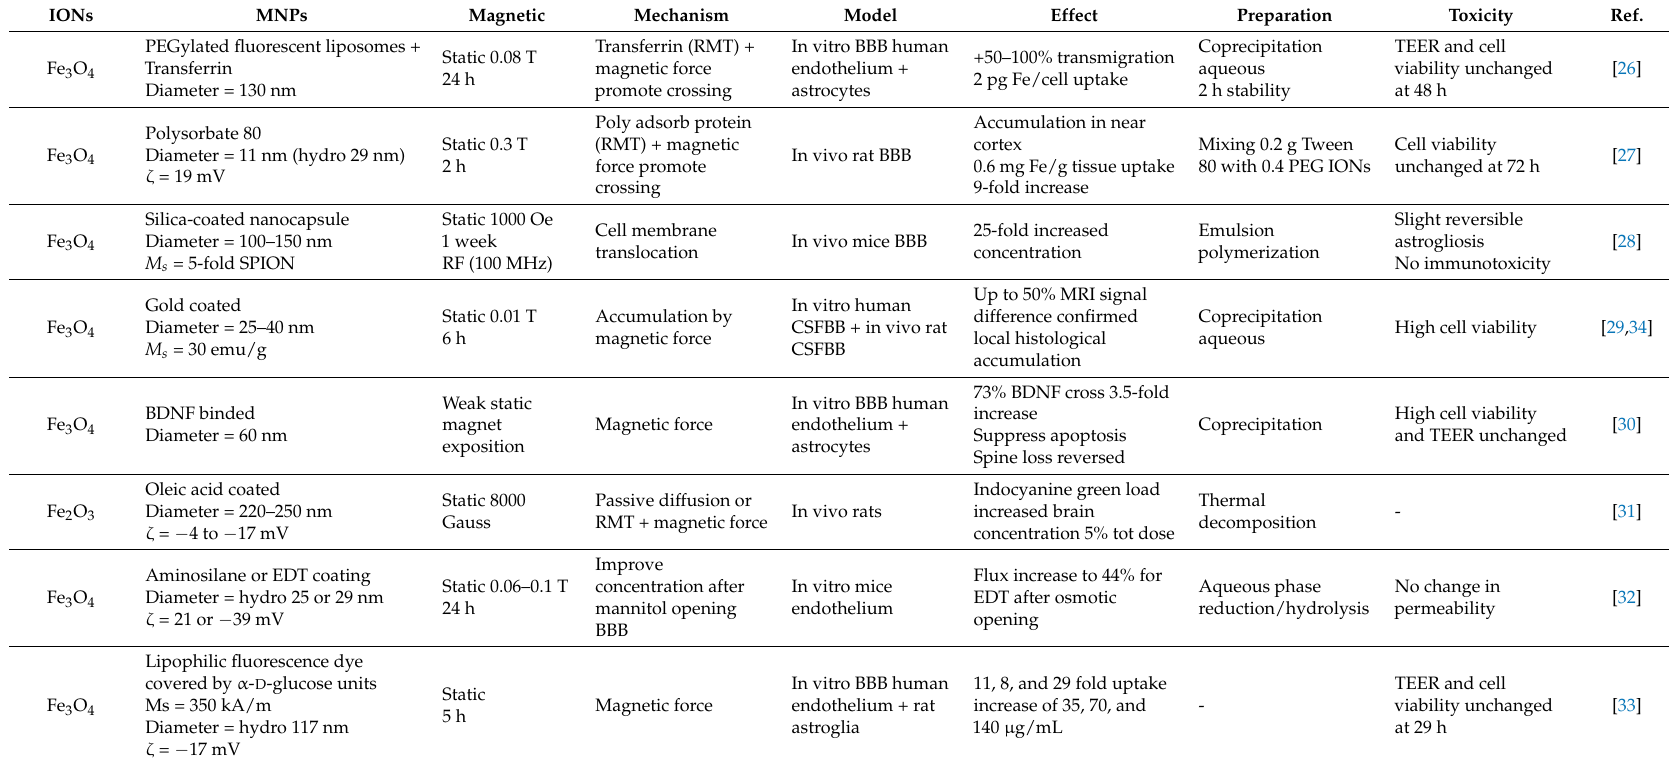
Table 1. MNPs Blood Brain Barrier